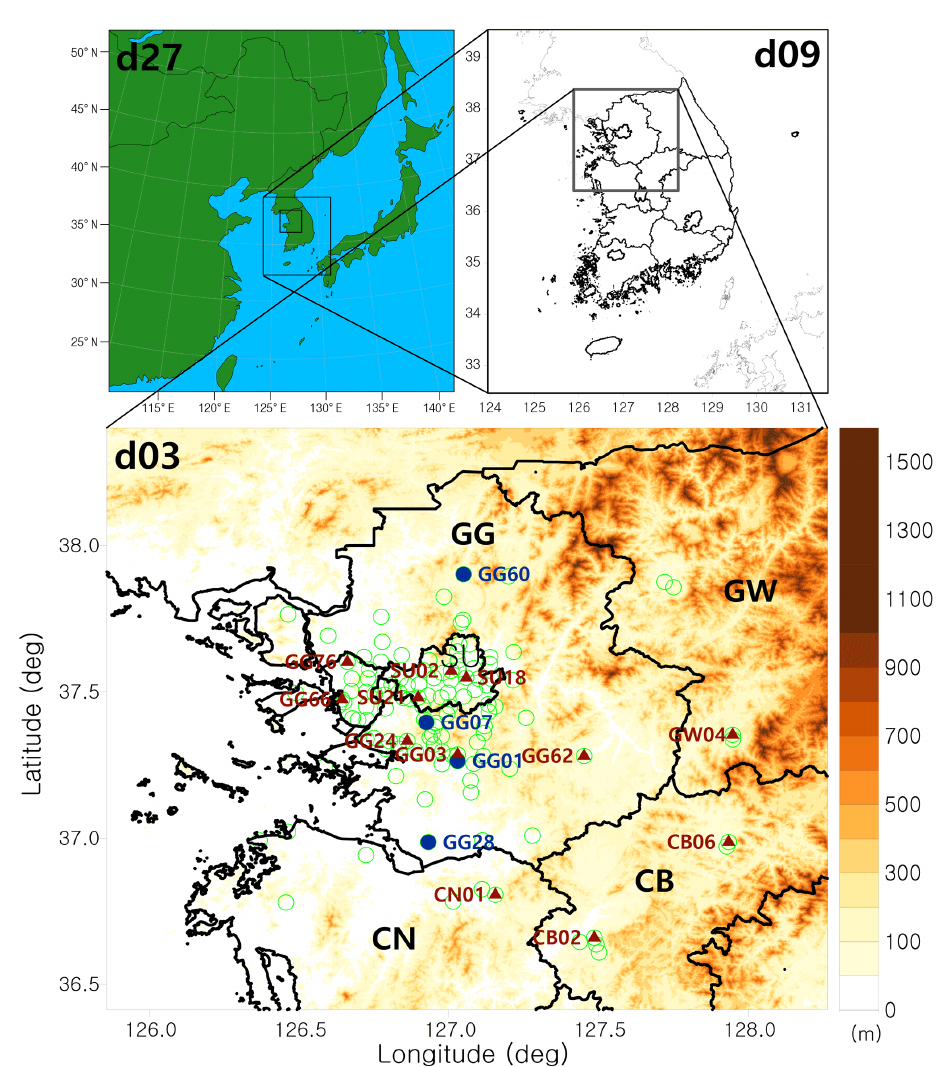
Figure 1. The model domains (d27, d09, and d03) for WRF (Weather Research and Forecasting). The domain size of CMAQ (Community Multiscale Air Quality) is mostly the same except that it has five grids fewer than WRF at lateral boundaries. The air quality monitoring sites at ground level are marked by green blank circles. Blue filled circles and red filled triangles indicate the selected locations for the idealized and realized background error covariance experiments, respectively. These experiments are conducted to investigate the diurnal variation of ozone during the assimilation window. Administrative district in the areas of Seoul, Gyeonggi-do, Gangwon-do, Chungcheongnam-do, and Chungcheongbuk-do is abbreviated to SU, GG, GW, CN, and CB, respectively, and also represented on the